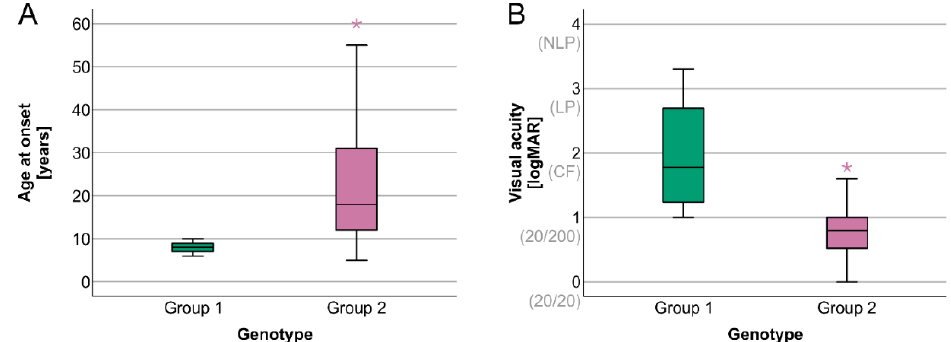
Figure 1. Boxplot chart showing the distribution of the ages at the onset of visual symptoms and visual acuities (VAs) in the two patient groups. Group 1 patients presented a significantly later age of onset ( A ) and significantly better VA ( B ). Horizontal lines represent median values, boxes represent half of the patients, and whiskers represent the remaining data, except in the case of the outliers (stars). LogMAR = logarithm of the minimum angle of resolution. Table 2. Distribution of patients according to the traditional ERG classification.